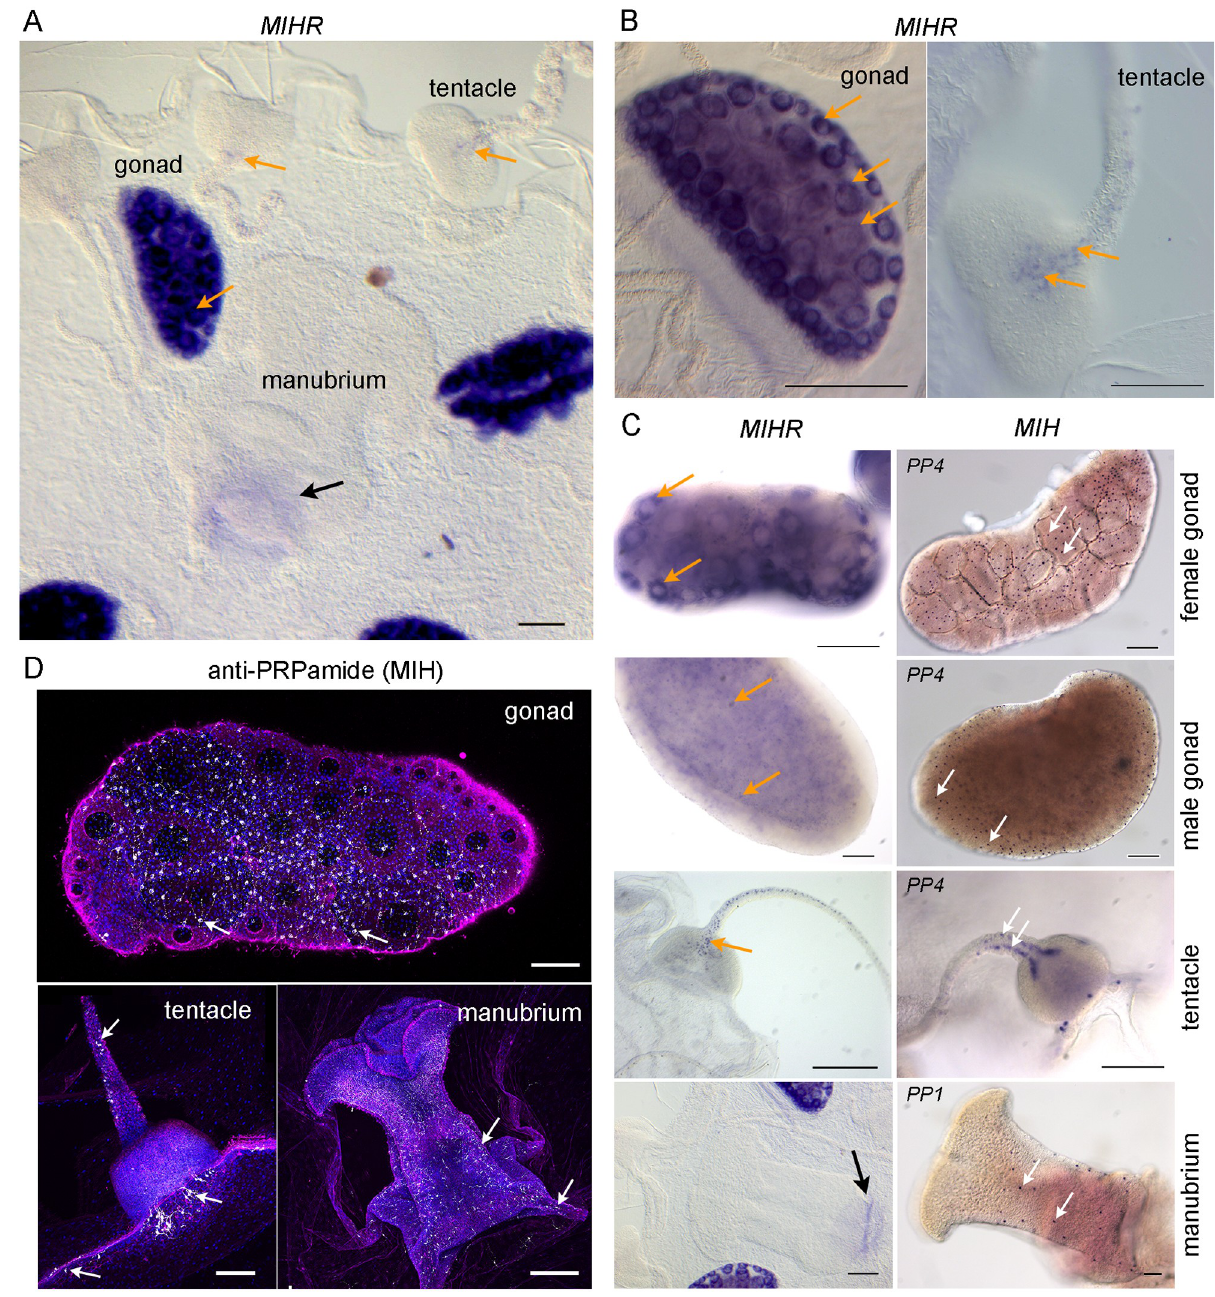
Fig 3. Sites of MIHR expression in the Clytia medusa. (A) In situ hybridization detection of MIHR mRNA in a young adult Clytia female medusa. Strong purple MIHR signal (orange arrows) was detected in oocytes within the gonads, as well as in scattered cells in tentacles. (B) Higher magnification images of MIHR mRNA detected in young adult medusae; with the gonad, each oocyte (e.g., at orange arrows) has an unstained nucleus. The intensity of labelling in individual oocytes decreases as they grow due to dilution of cytosol with yolk. In the tentacle, a row of individual MIHR-positive putative neural cells can be clearly distinguished leading from the center of the bulb on its oral face. (C) Comparison of the distribution of the MIH receptor and ligand expressing cells in different medusa structures as labelled, detected by in situ hybridization using probes to MIHR (top row) and to the MIH peptide precursors PP1 and/or PP4 as indicated (bottom row). Orange arrows point to oocytes, developing spermatozoa and tentacle MIHR cells, and white arrows indicate MIH cells. The focal plane in the male gonad image is through the center to illustrate the position of the MIH cells in the ectodermal layer. Weak staining at the base of the manubrium (black arrow) in A and B is frequently observed with probes for many genes and is probably due to a specific trapping of the color reagent. Scale bars: 100 μ m. (D) Confocal images of the three main sites of MIH-expressing cells (white arrows) in medusae, visualized using anti-PRPamide antibody (MIH: white), anti-tyrosinated tubulin (magenta), and Hoechst staining of nuclei (blue). Summed z-stacks are shown in all cases except for the gonad tubulin and DNA staining, where a single plane was selected through the center of the gonad. All scale bars: 100 μ m. MIH, maturation-inducing hormone; MIHR , MIH receptor. https://doi.org/10.1371/journal.pbio.3000614.g003 PLOS Biology | https://doi.org/10.1371/journal.pbio.3000614 March 3,